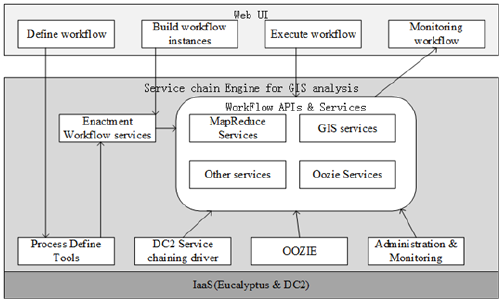
Figure 3. Service chaining for geospatial